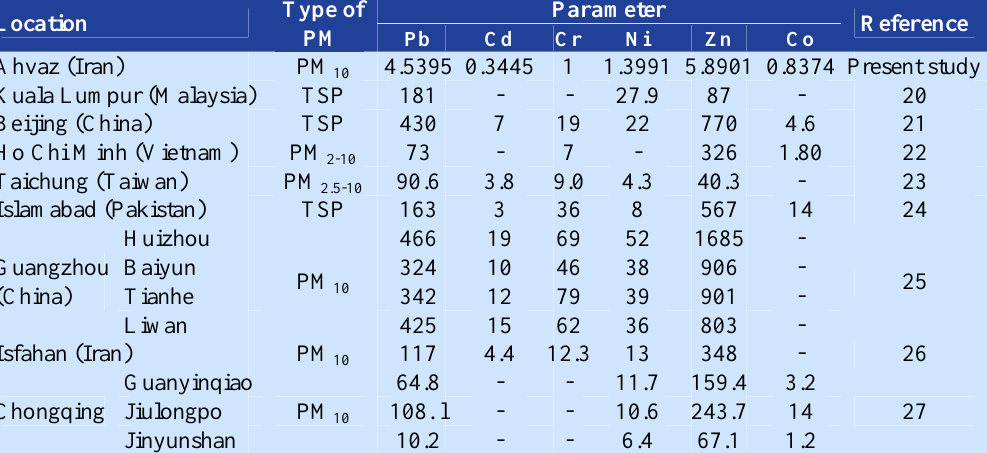
Table 2. The heavy metals mean concentration (ng/m3) in PM 10 samples in comparison with other Asian